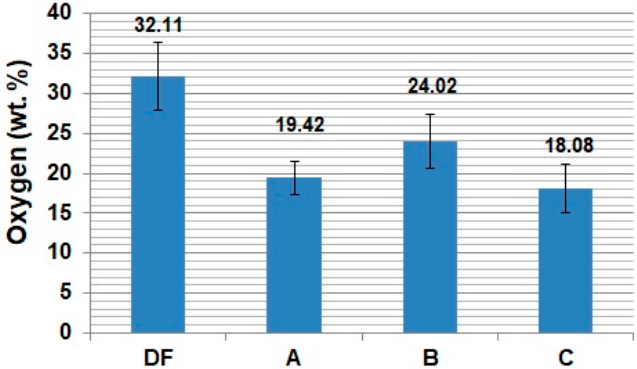
Figure 7. Oxygen content in wear products (p = 30 MPa).